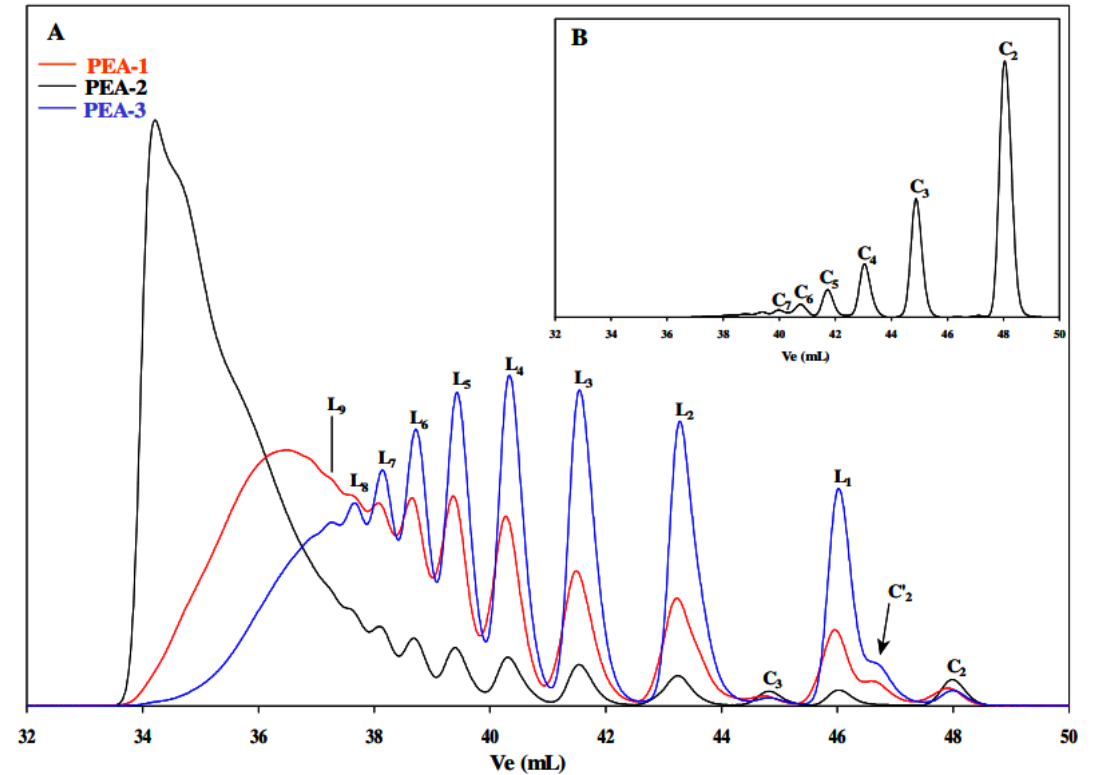
Figure 4. SEC chromatograms of ( A ): PEA-1, PEA-2, and PEA-3: identification of linear dihydroxy macromolecules (Ln), cyclic oligomers with and without DEG motif (C’n and Cn respectively); ( B ) sample obtained after the cyclodepolymerization of PEA-2.